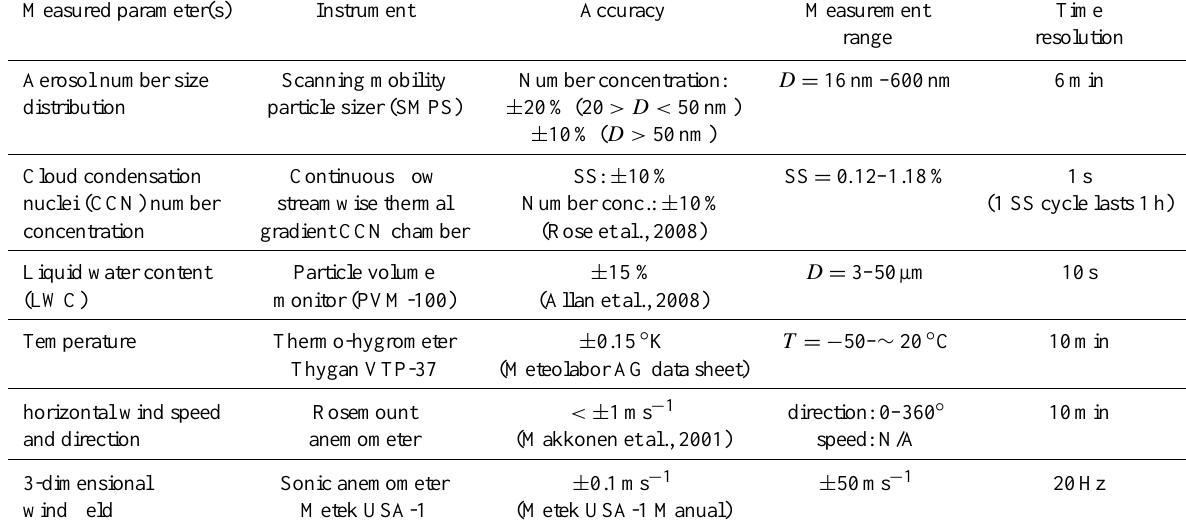
Table 1. Instrumentation for